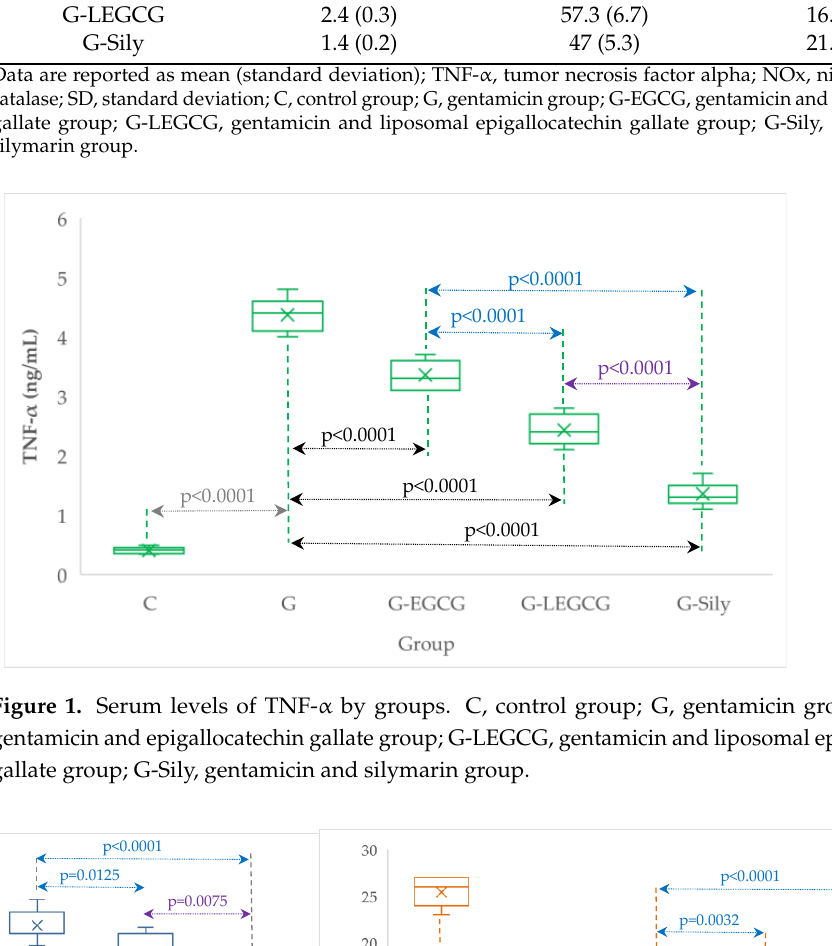
Table 4. Serum markers of inflammation, oxidative stress/antioxidant balance by groups after gen- tamicin administration: comparative effect of EGCG, LEGCG, and silymarin.